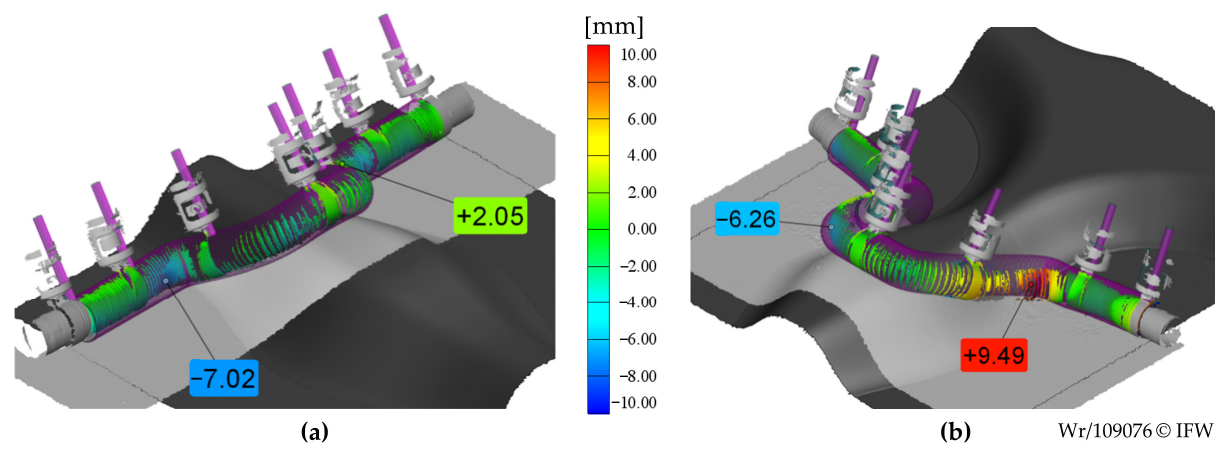
Figure 11. Deviation analysis of the deformed consolidation element with the simulated shape with areas of over-actuation ( a ) and under-actuation ( b ).